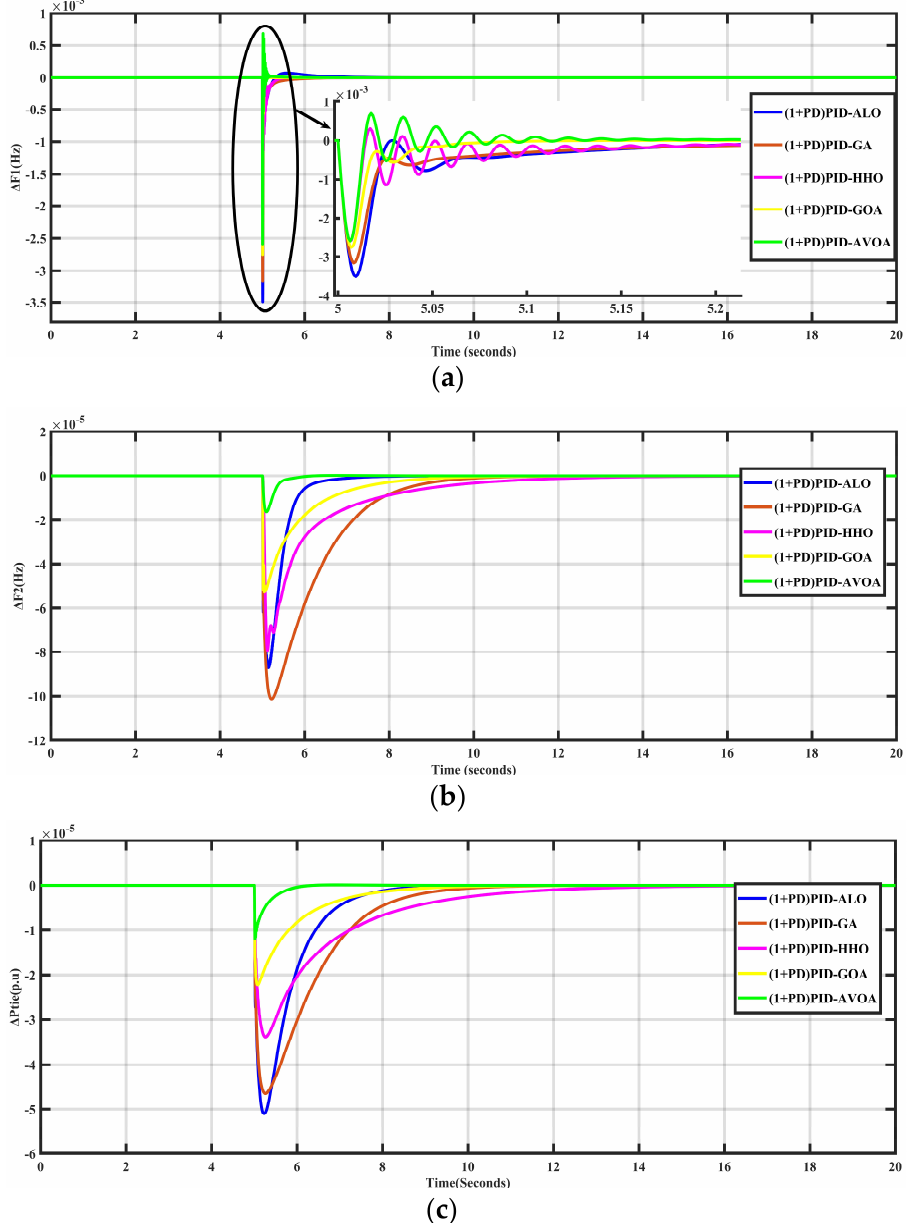
Figure 6. ( a ) The deviation of frequency in Area-1 ( ∆ F 1 ); ( b ) the deviation of frequency in Area-2 ( ∆ F 2 ); ( c ) the deviation of tie-line power ( ∆ P tie ) for 10% load change in Area-1 under the influence of (1+PD)-PID controller and different optimization algorithms.